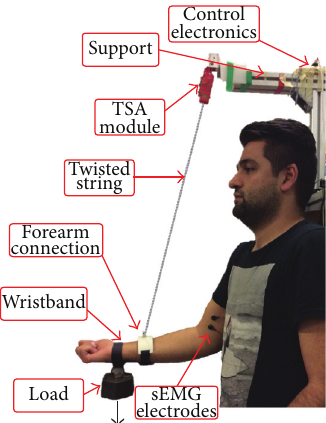
Figure 10: Experimental setup as an assistive device.